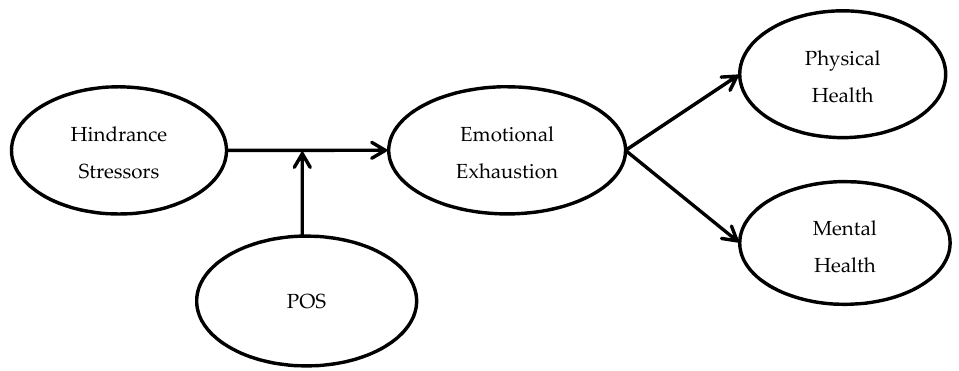
Figure 1. Hypothesized model. POS = perceived organizational support.